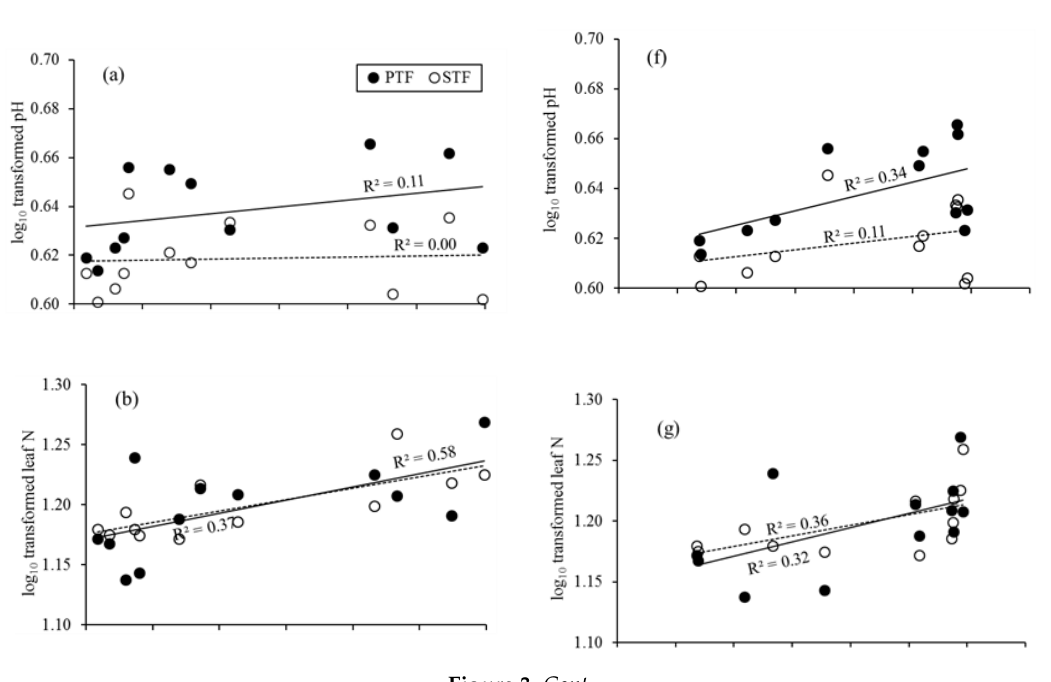
Figure 2. Litterfall in relation to precipitation. Solid circles represent the site primary tropical forest (PTF) and empty circles the site secondary tropical forest (STF).